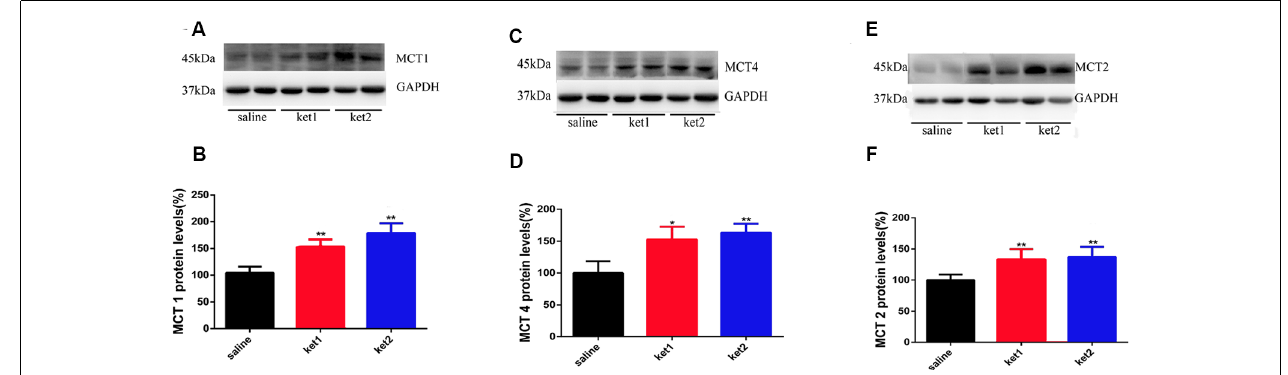
FIGURE 5 | Changes of hippocampal cytoplasm MCT1, MCT4 and MCT2 protein levels after 6 months of ketamine administration in different groups as revealed by Western blot. (A,B) Significant increase of MCT1 expression levels were seen in ket2 and ket1 group comparing with control group respectively ( F (2,27) = 5.943, F (2,27) = 5.477, ** p < 0.01, respectively). (C,D) Significant increase of MCT4 expression levels were seen in ket2 and ket1 group comparing with control group ( F